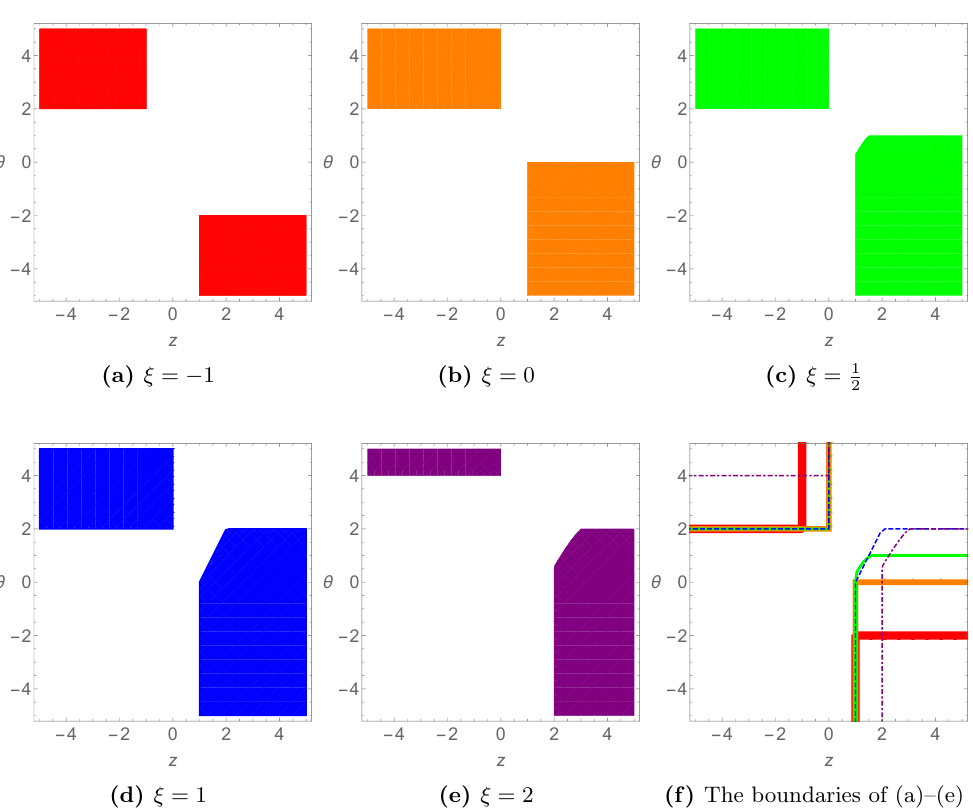
Figure 1. Prototypical cases of table 1 ( p =